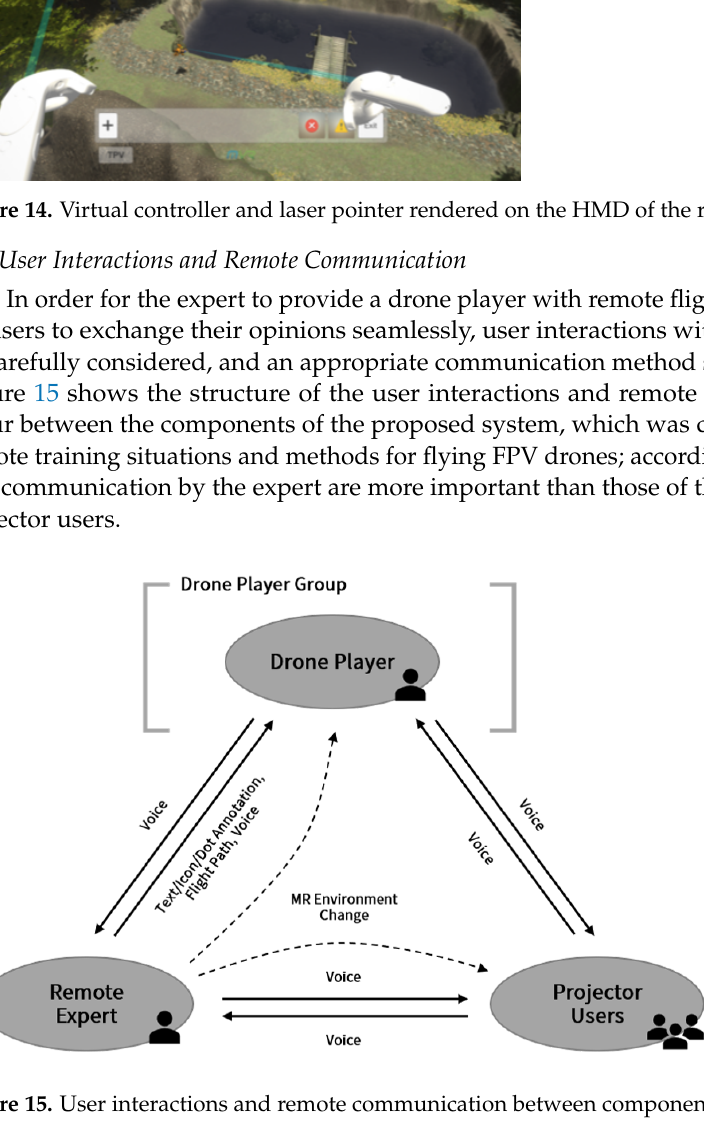
Figure 15. User interactions and remote communication between